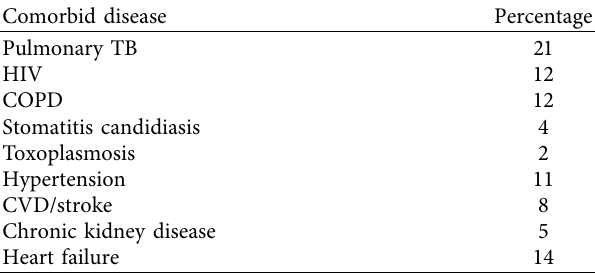
Table 5: Comorbid diseases in hospitalized pneumonia patients. Comorbid